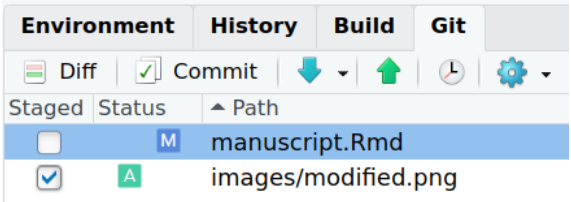
Figure 2. The Git pane in R Studio, showing manuscript.Rmd modified but unstaged and modified.png newly added and